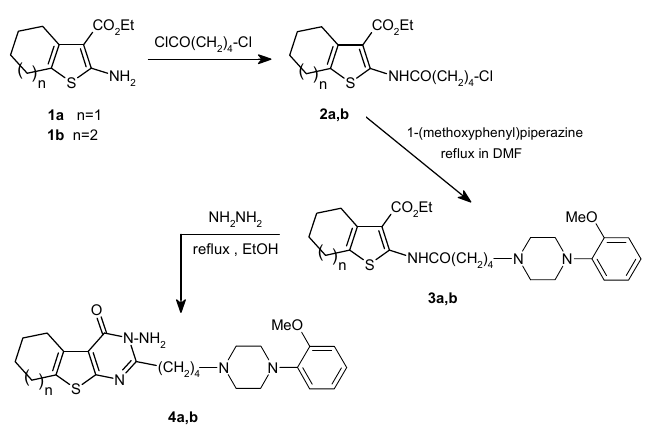
Table 1. 1 H-NMR, 13 C-NMR and HMBC correlations of 4a (CDCl